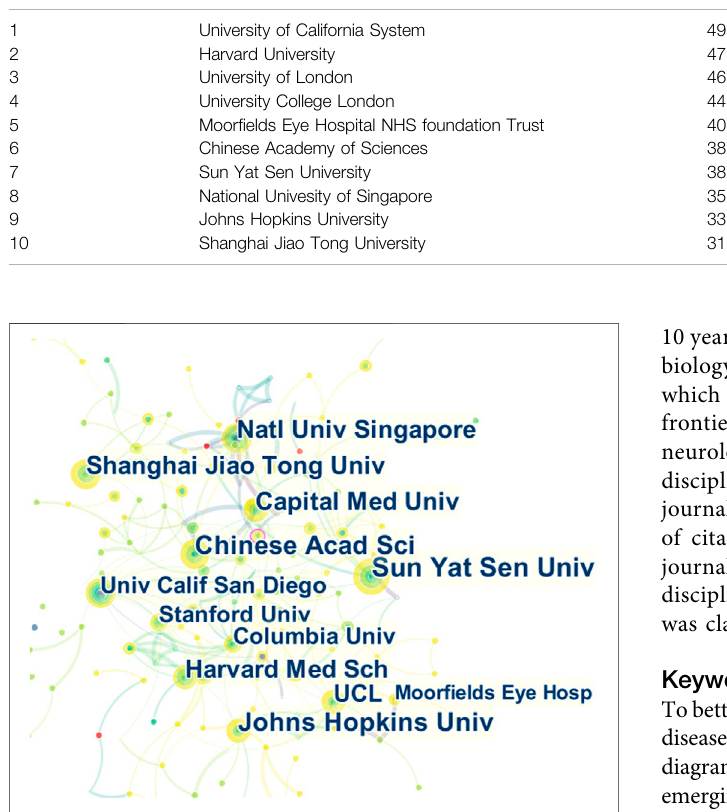
TABLE 2 | Top 10 Institutions with publications on the application or the use of AI in the diagnosis of ophthalmic diseases from 2012 to 2021. Rank